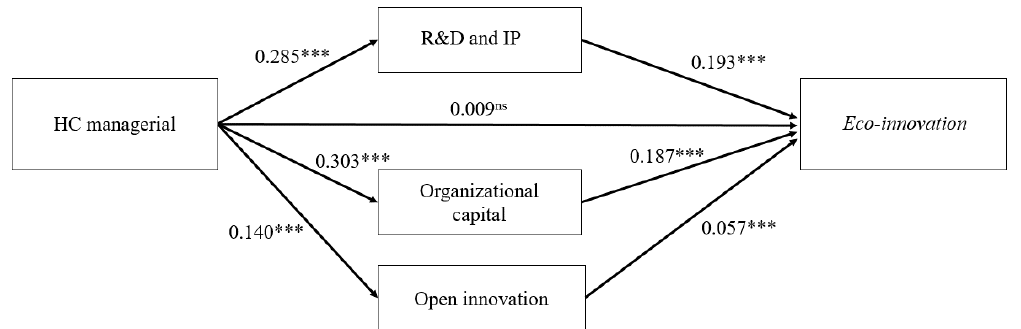
Note: The figure reports the coefficients of the structural equation model including the control variables.